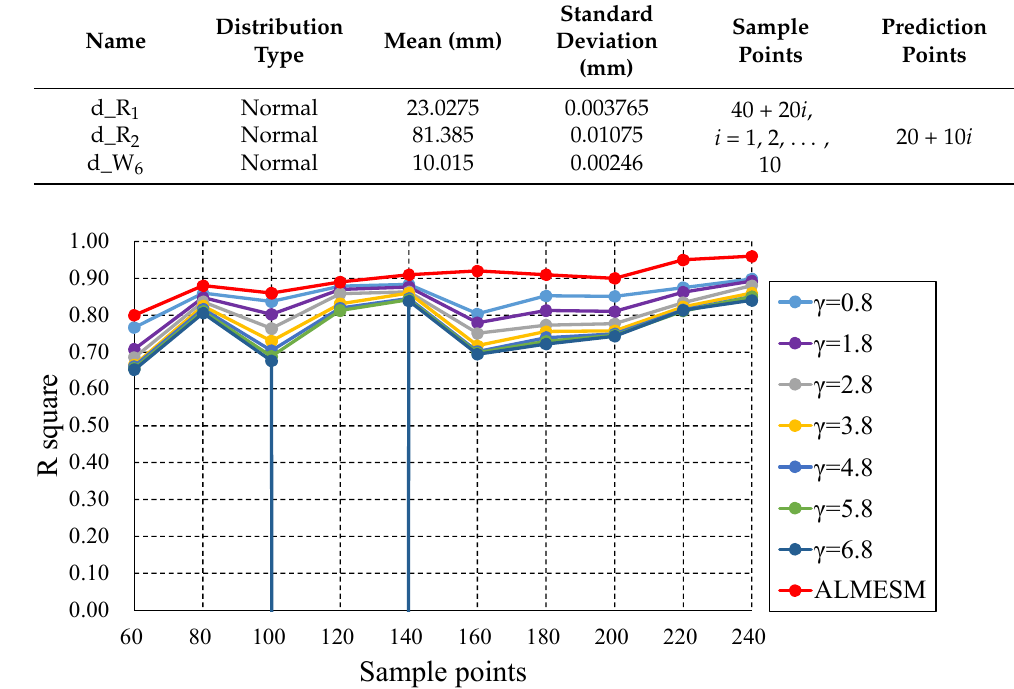
Figure 12. R-squared comparison of ALMESM and the original LME approximation with different globally unified γ under different numbers of sample points for approximating the LCF life of the GH720Li turbine disk.